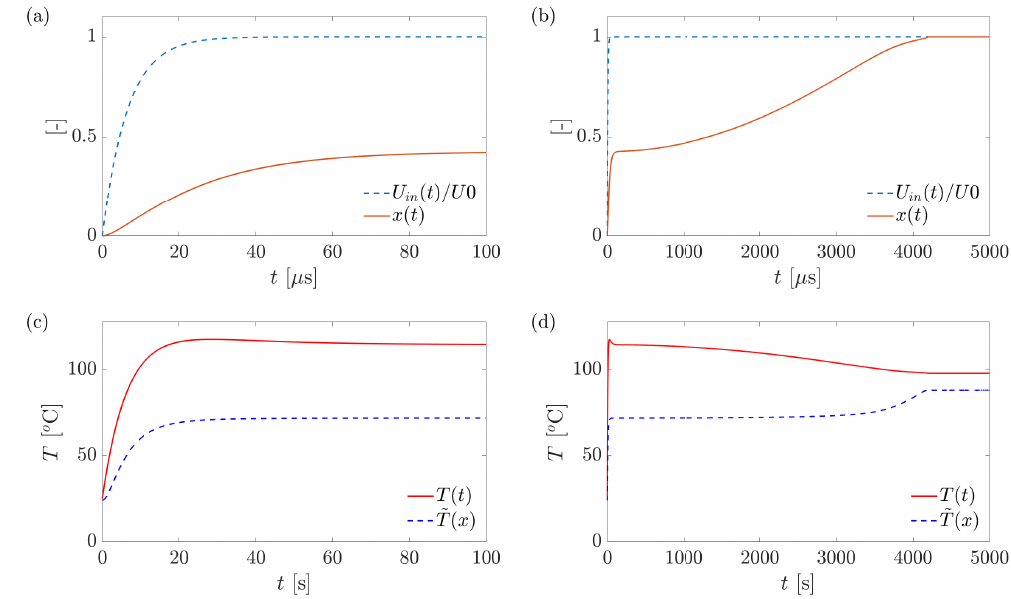
Figure 15. Results of a simulation of our typical experiment presented in Figure 4. ( a , b ) The time evolution of the energy input into the wire normalized by its maximum value; U in ( t ) / U 0 , is presented in the blue dashed curve, and the evolution of the volume fraction of austenite, x ( t ) , in the solid red curve. ( c , d ) The temperature evolution of the wire in time, T ( t ) , is presented in the red solid curve, and the evolution of the volume-fraction-dependant transition temperature, ˜ T ( x ) , in the blue dashed curve. ( a , c ) A zoom-in into the initial 100 µ s after the onset of the heating